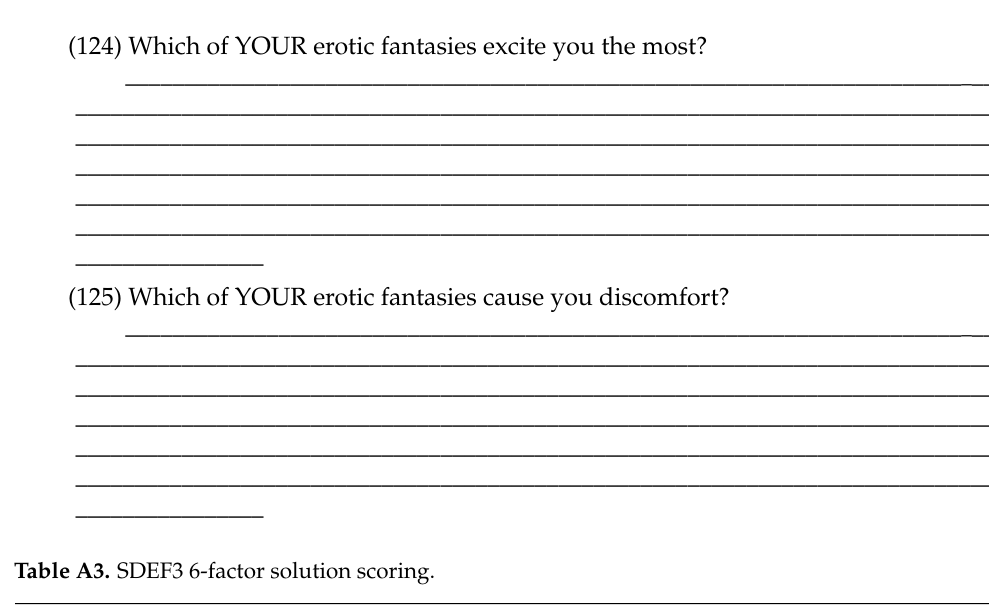
Table A2. Questionnaire.